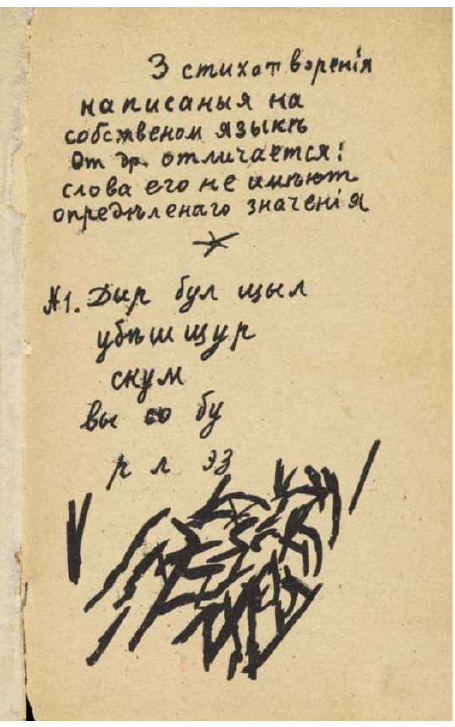
Figure 3: Kruchenykh’s 1913 poem “Dyr bul